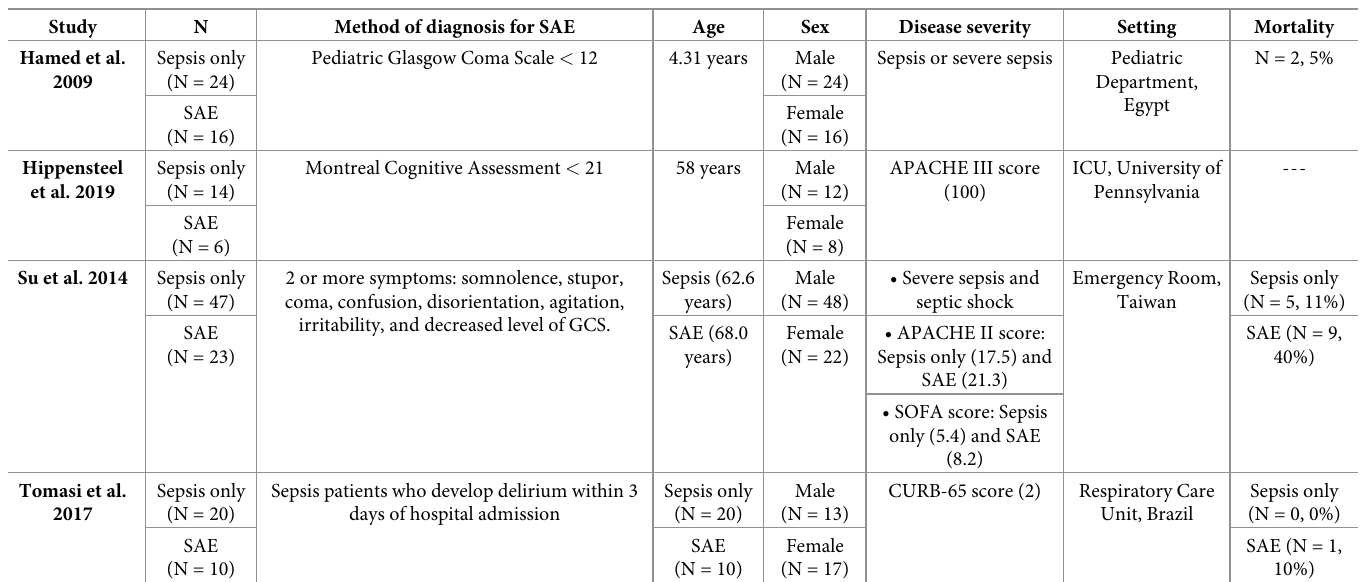
Table 1. Characteristics of included studies.